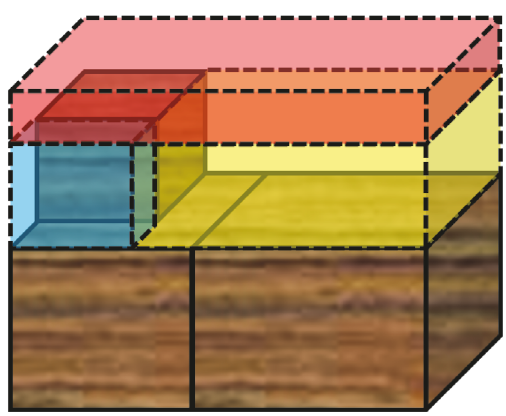
Figure 4: X-Y-Z division mode.